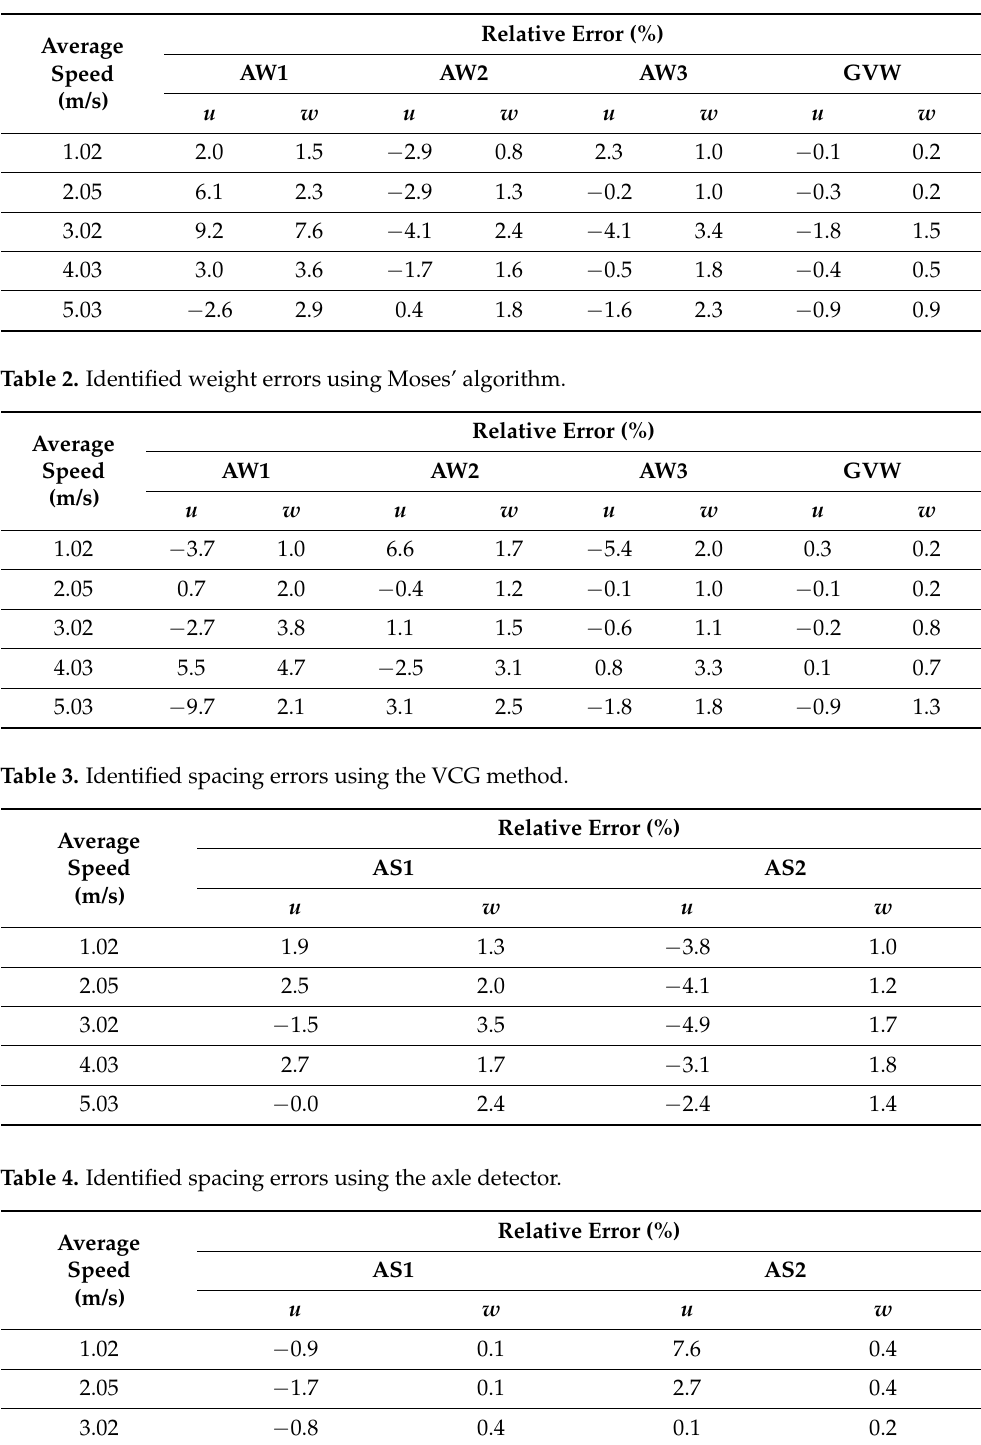
Table 1. Identified weight errors using the VCG method.